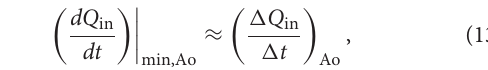
dQ in / dt , from the aortic flow waveform, Q in ( t min,Ao (cid:1)(cid:12) (cid:0) (cid:12)